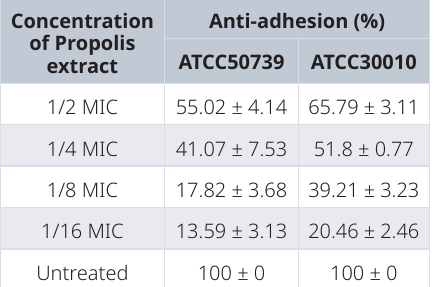
Table 2. Effects of Propolis extracts on anti-adhesion of A. castellanii ATCC50739 and ATCC30010 trophozoites.